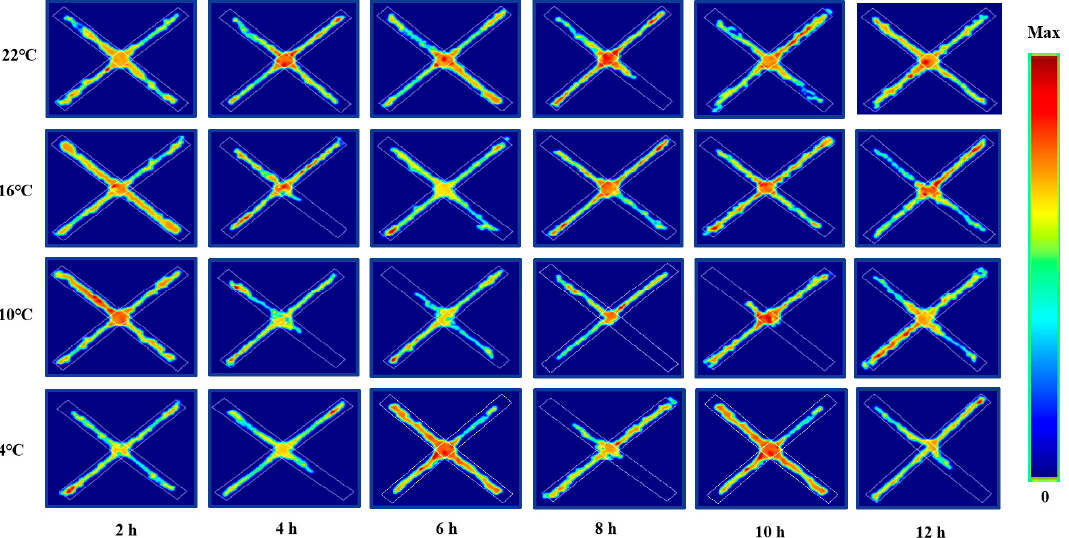
Figure 7. Movement trajectory map of mice in elevated plus maze test under different intensity of cold exposure.